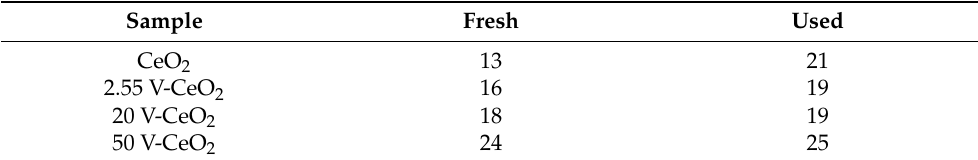
Table 5. Average crystallite size (<L>, nm) of the fresh and used catalysts.